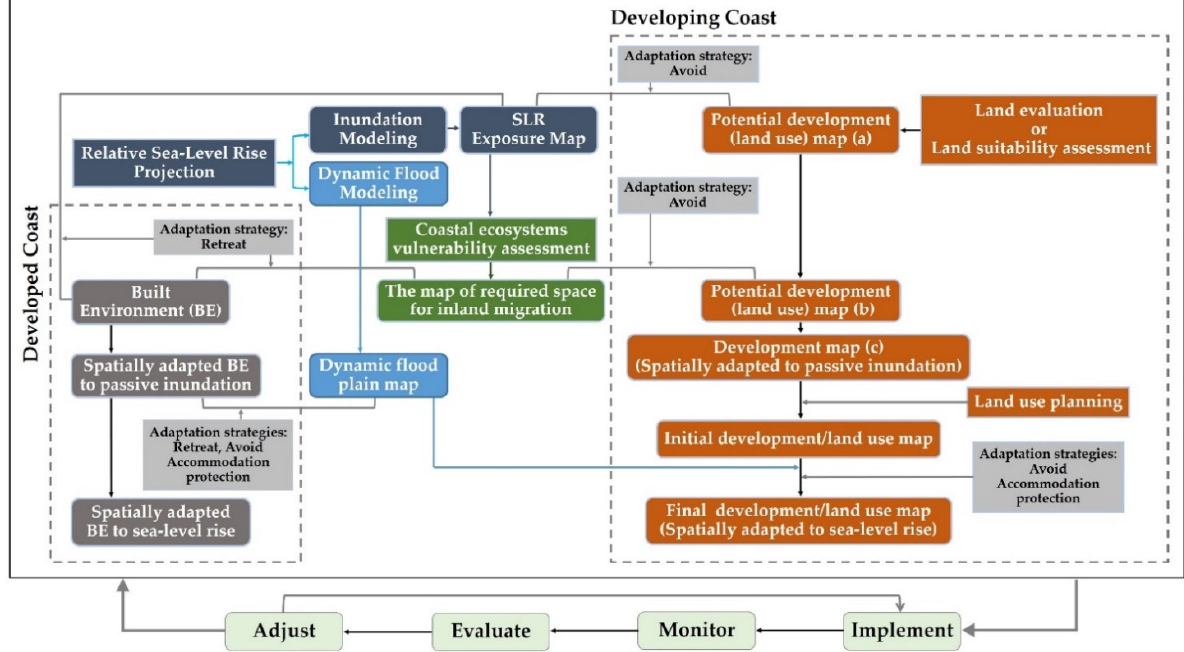
Figure 7. A Spatial Integrated SLR Adaptive Management Plan Framework (SISAMP) for developing coasts. (The different colors were used to improve the conceptual model visualization. For example, the elements of land management tools in developing coasts are shown in orange, and adaptation framework for developed coasts are shown in dark gray).